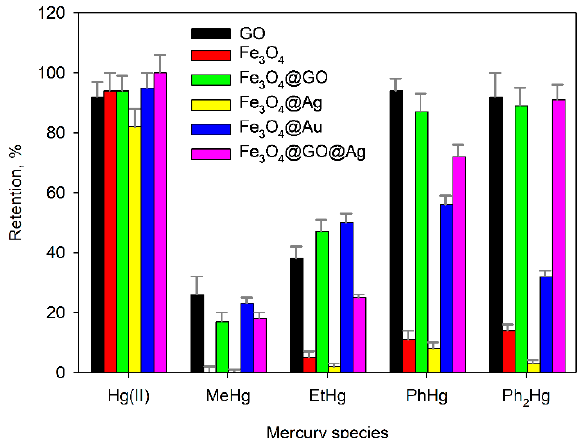
Figure 3. Retention of different forms of mercury in various adsorbent materials using TRIS as the buffer solution at pH = 9. Error bars correspond to the standard deviation of three experiments.